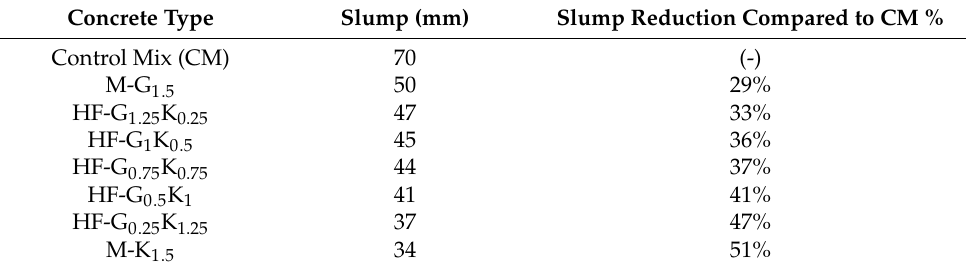
Table 6. Slump behavior of CM and hybrid fiber